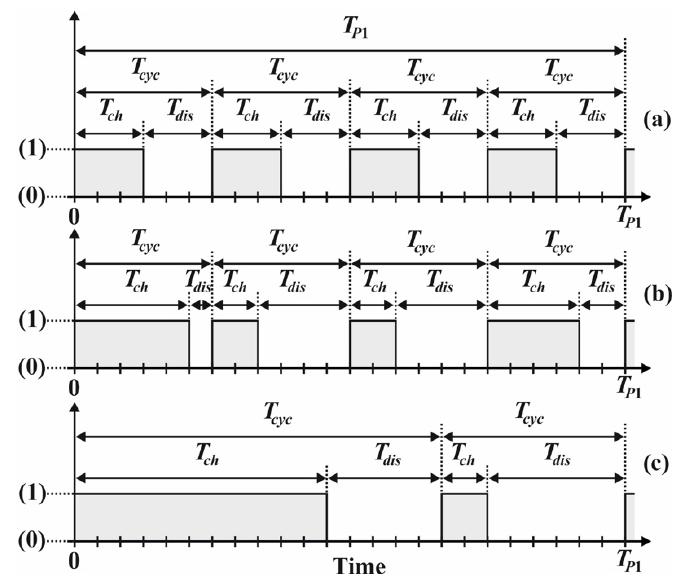
Figure 2. Different operation modes for BSSs: ( a ) Mode1, ( b ) Mode 2, ( c ) Mode 3. Figure 2. Di ff erent operation modes for BSSs: ( a ) Mode1, ( b ) Mode 2, ( c ) Mode